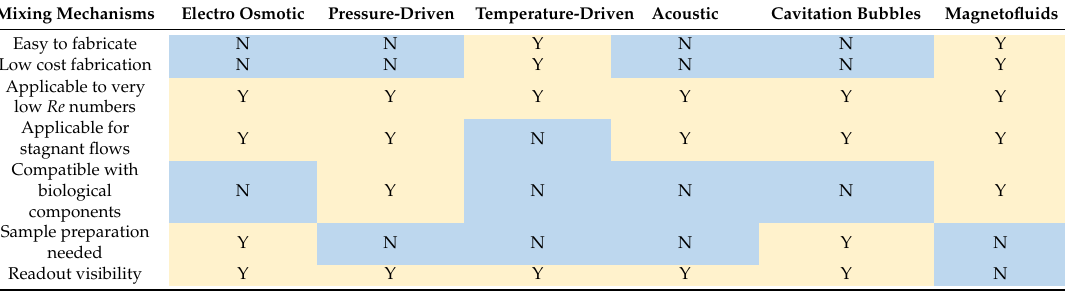
Table 1. Comparison of the di ff erent mixing